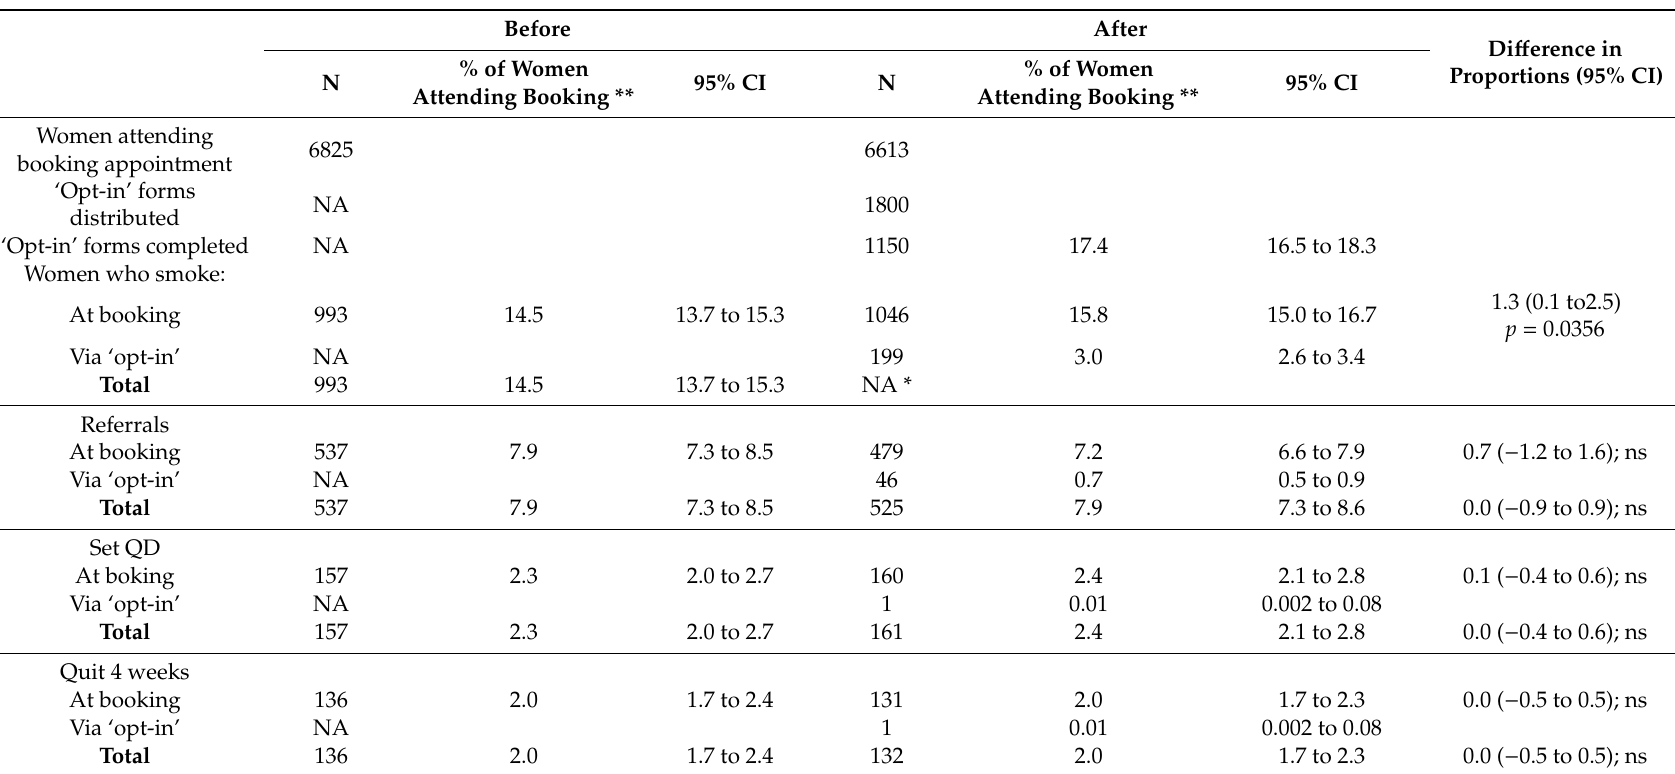
Table 1. Referrals of pregnant smokers received by stop smoking services and outcomes before and after implementation of the ‘opt-in’ referral pathway. Before